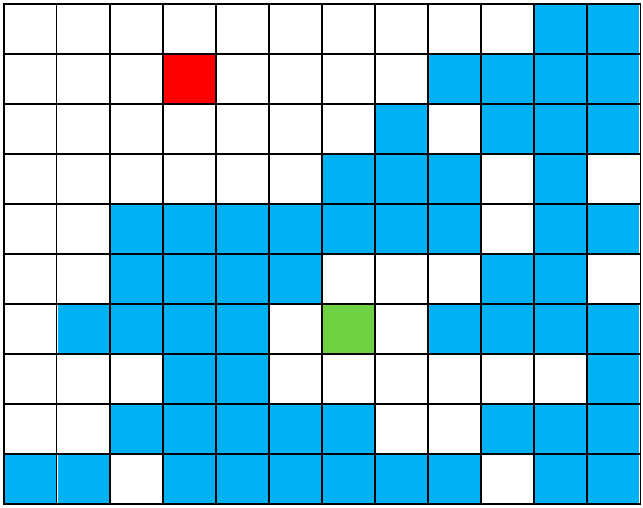
Figure 2. Illustration of the DEM interpolation. Blue points are ground points, green and red points are points to be interpolated. Here, raw data exist around the green point, so a more accurate prediction can be obtained during interpolation. On the contrary, the red point can only rely on the data in the lower right corner to make predictions. There is no original data in the upper left corner, so it is difficult to obtain correct predictions.